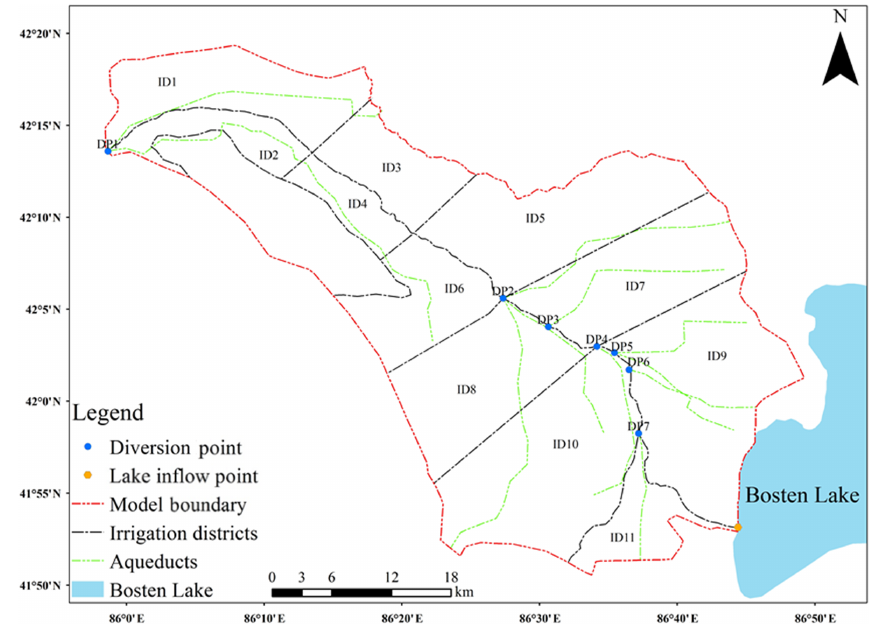
Figure 5. The locations of surface water diversion points and subdomains of irrigation districts for groundwater